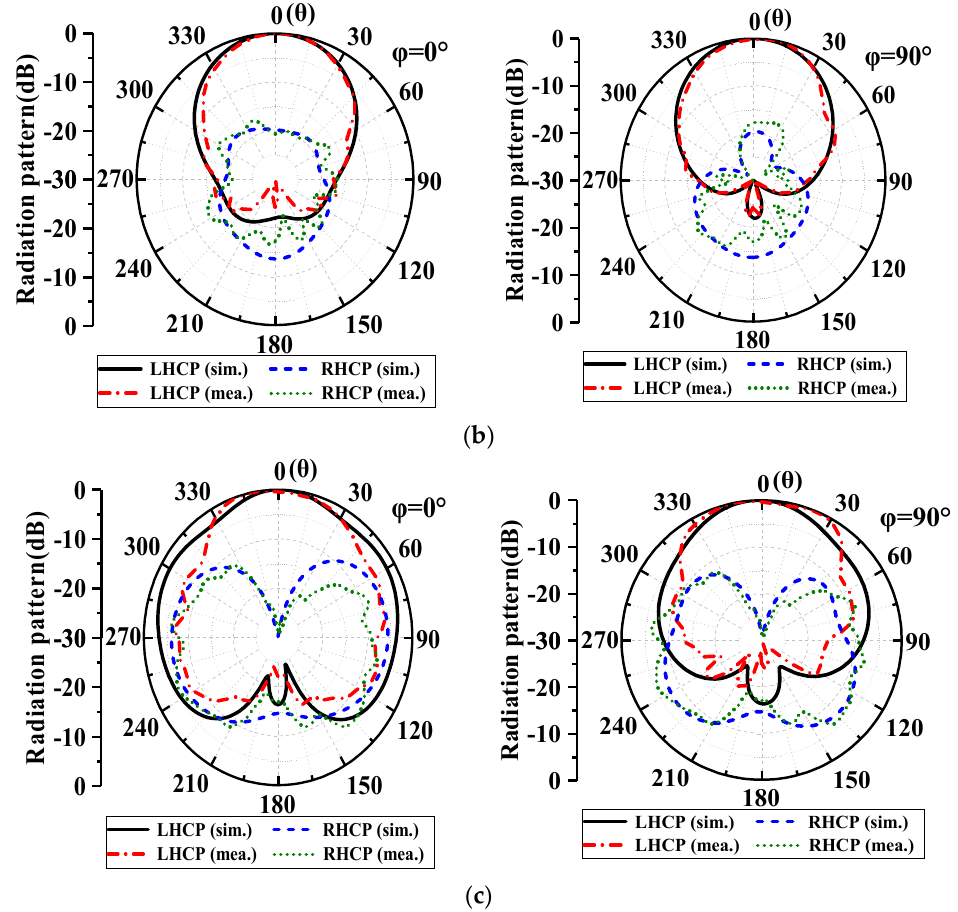
Figure 9. Simulated and measured normalized radiation patterns. ( a ) 1.5 GHz. ( b ) 1.74 GHz. ( c ) 2 GHz.